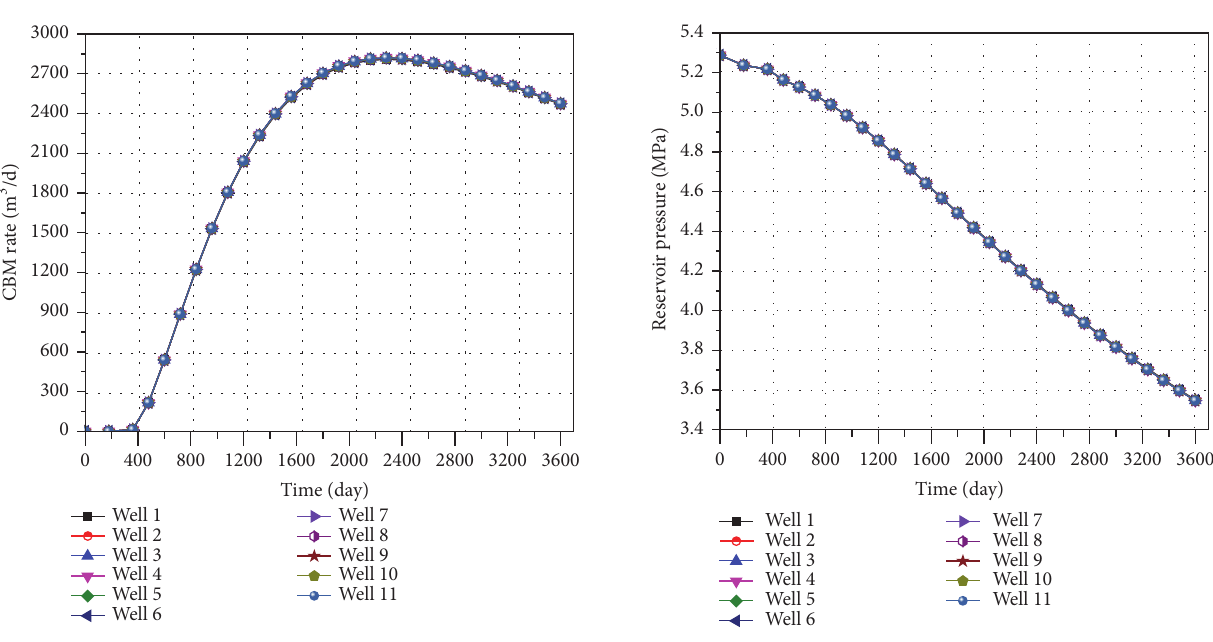
Figure 9: Reservoir